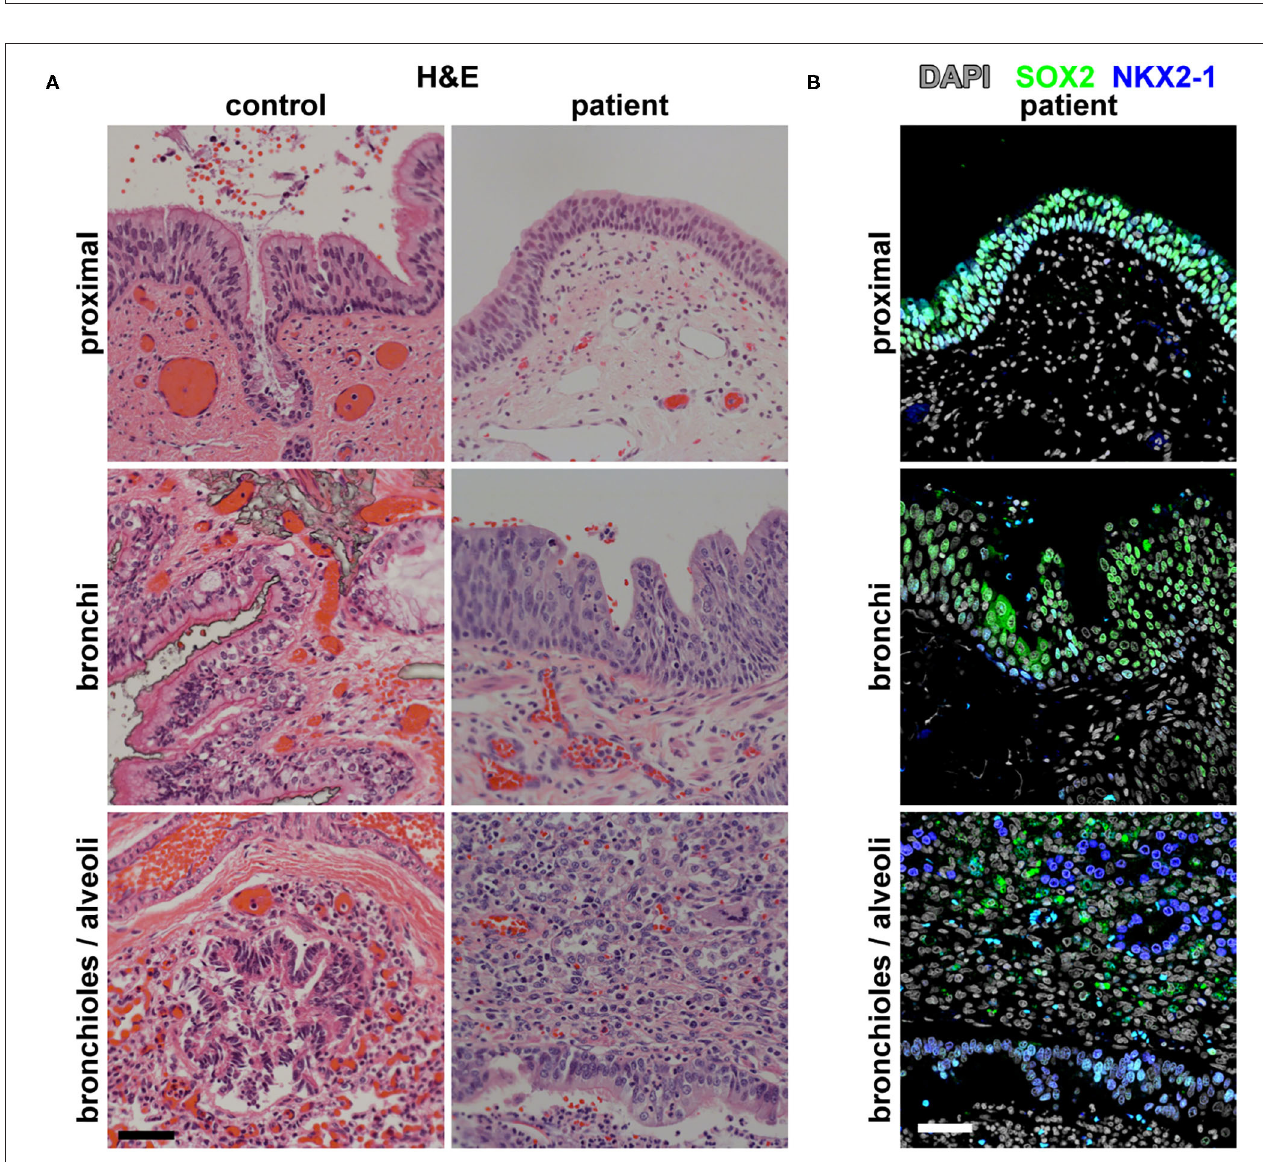
FIGURE 2 | Histological and molecular analysis of the identity of the broncho-esophageal fistula and more distal airway. (A) H&E staining of the patient vs. control tissues from the “proximal” epithelium (broncho-esophageal fistula vs. trachea, respectively), bronchi, and distal bronchioles and alveoli. (B) Immunofluorescence staining of patient tissue for transcription factors SOX2 and NKX2-1 in sections from the proximal epithelium (broncho-esophageal fistula vs. trachea, respectively), bronchi, and distal bronchioles and alveoli. Scale bars represent 50 µ